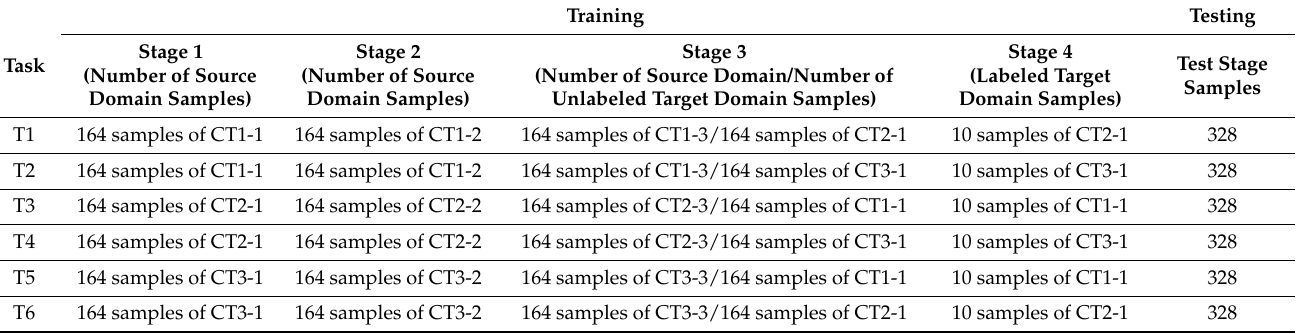
Table 5. Data sample size at each stage.